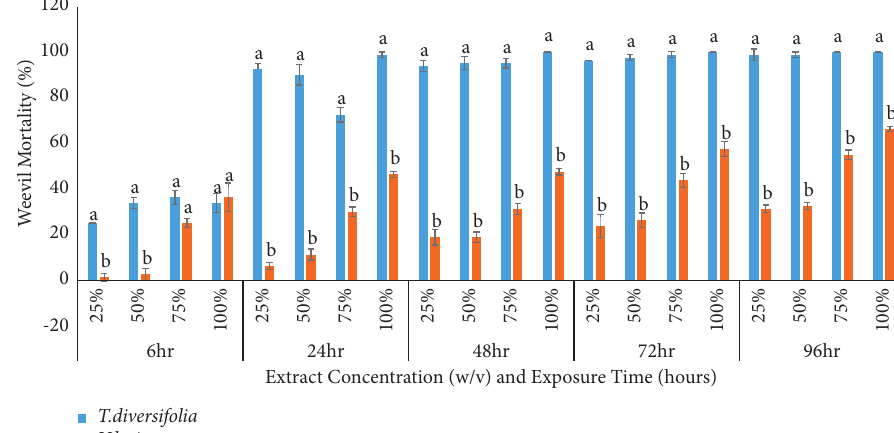
Figure 1: Comparison of the contact toxicity effects (corrected percent mortality) of the DCM leaf extracts of T. diversifolia and V. lasiopus against S. zeamais . Bar graphs with different superscripts within the same concentration are significantly different at the respective test period ( p < 0 . Table 7: Contact toxicity effects of the ethyl acetate leaf extract of T. diversifolia against S. zeamais . Group